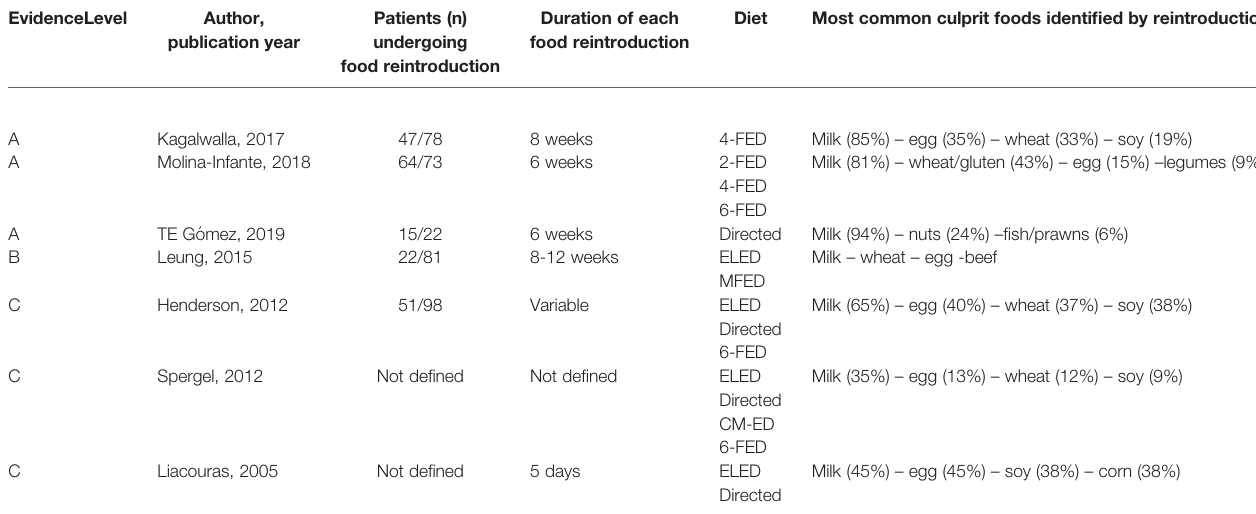
TABLE 8 | Overview of studies evaluating the reintroduction of previously eliminated foods.